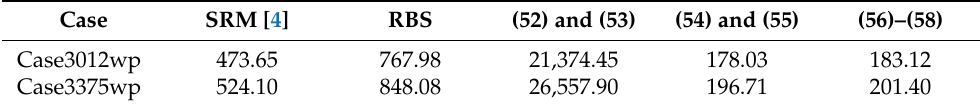
Table 8. Solution times (ms) for ill-conditioned cases.